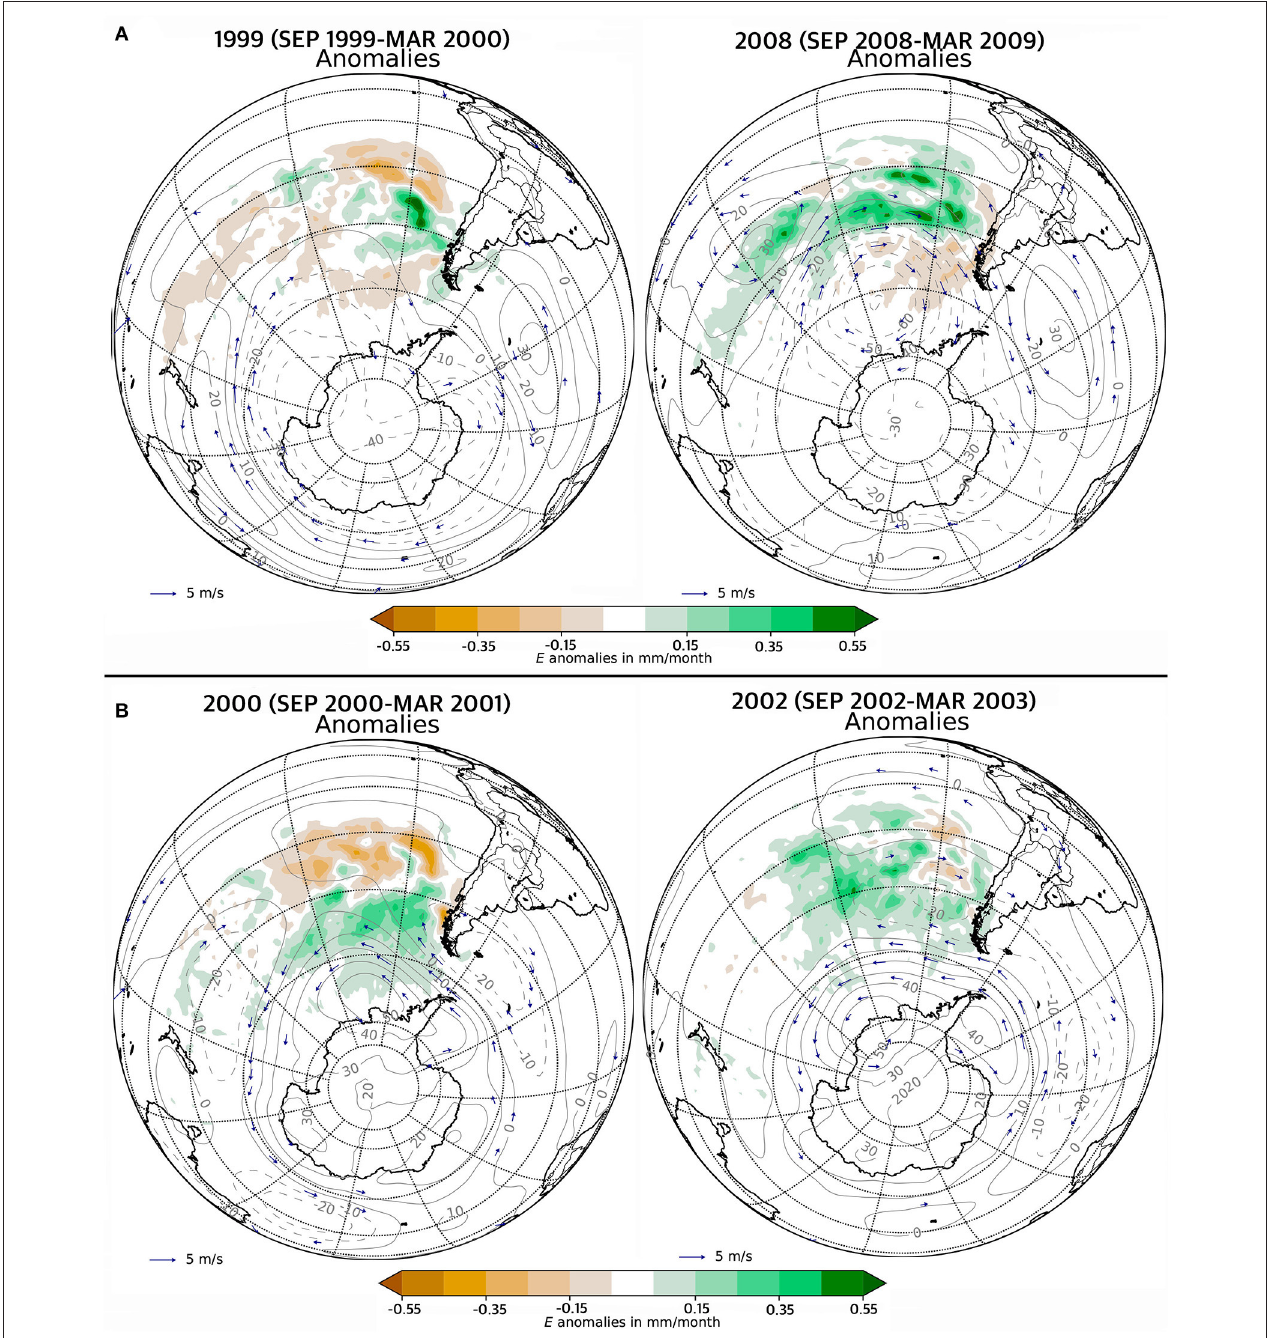
FIGURE 8 | Mean moisture source anomalies in mm/month for the chosen (A) positive and (B) negative extreme years. Orange areas highlight a moisture source deficit and green areas a surplus during the respective period. The anomalies of the 800 hPa geopotential height and wind field anomalies exceeding 1.5 m/s are depicted as well. Interval of the Meridians are 30 ◦ , of the Parallels 15 ◦